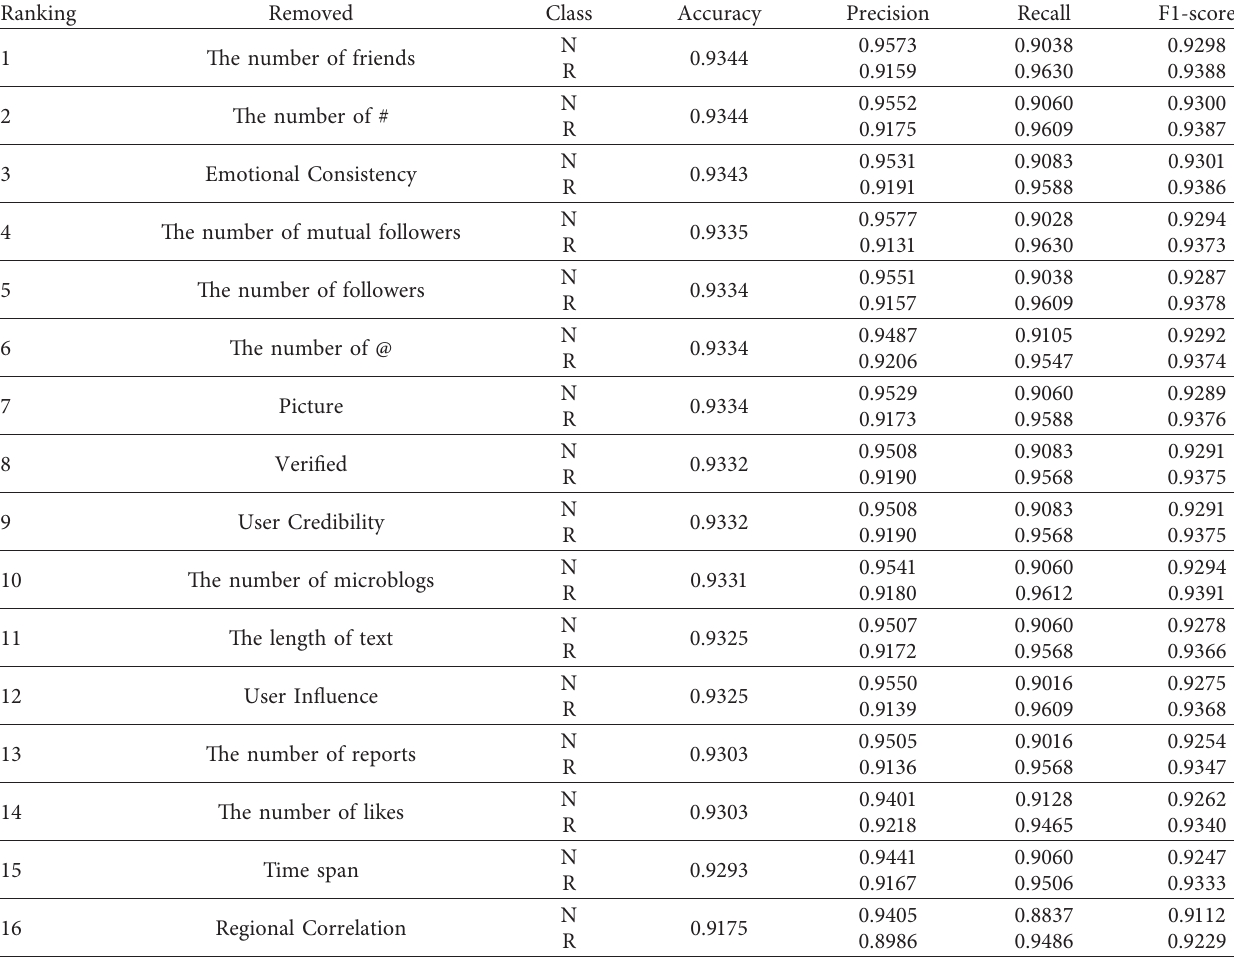
Table 4: The effectiveness of each feature in F